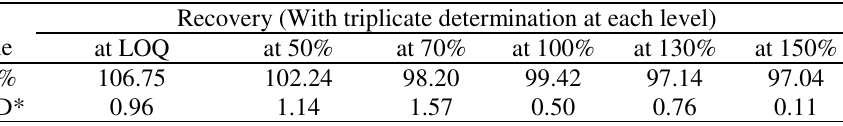
Table 3. Accuracy results for aniline